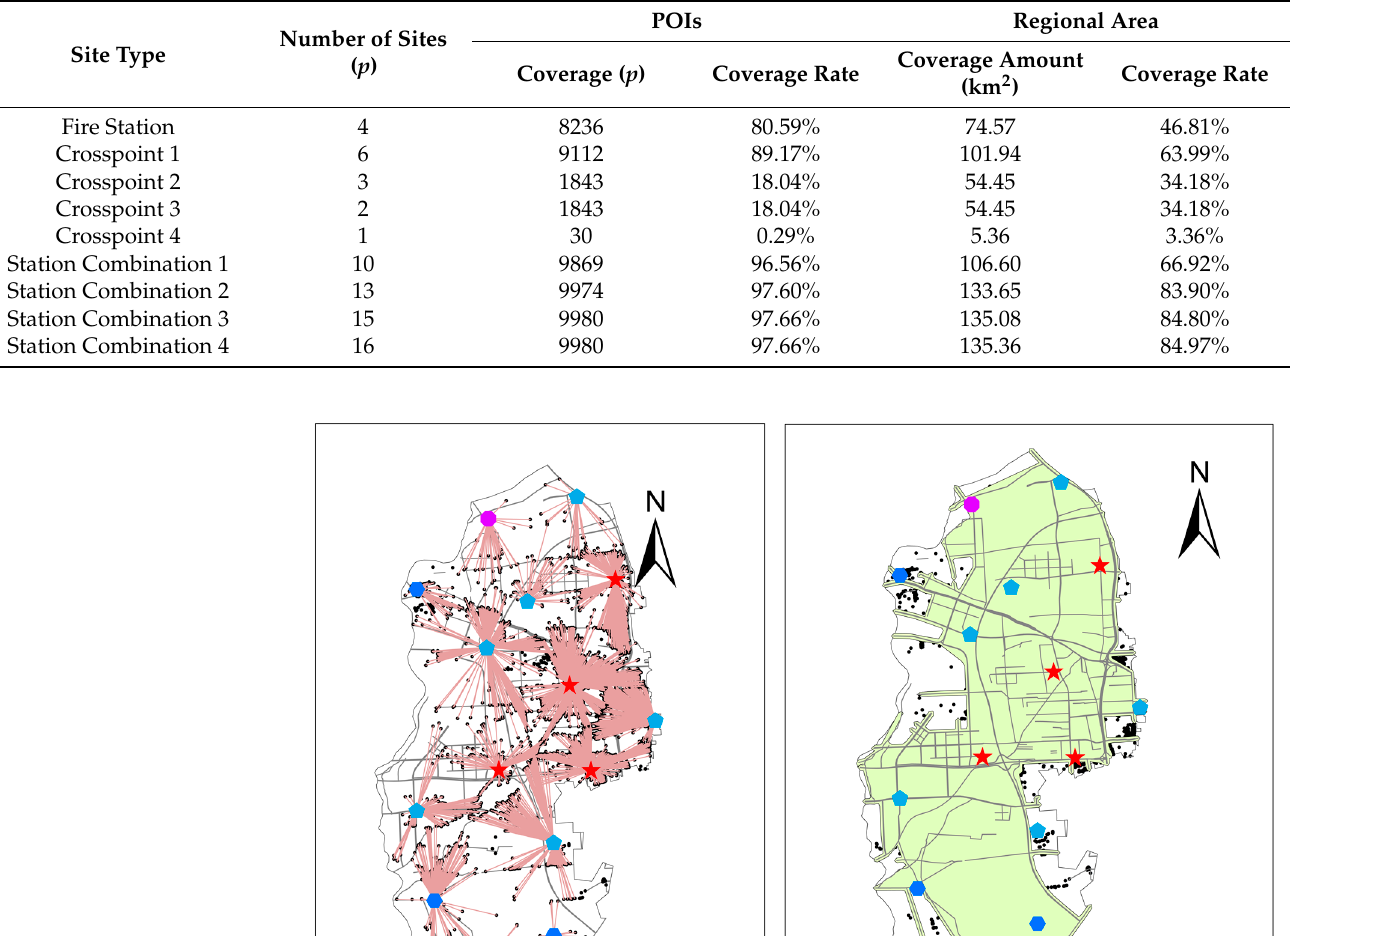
Table 4. Coverage of POIs and area by crosspoints.